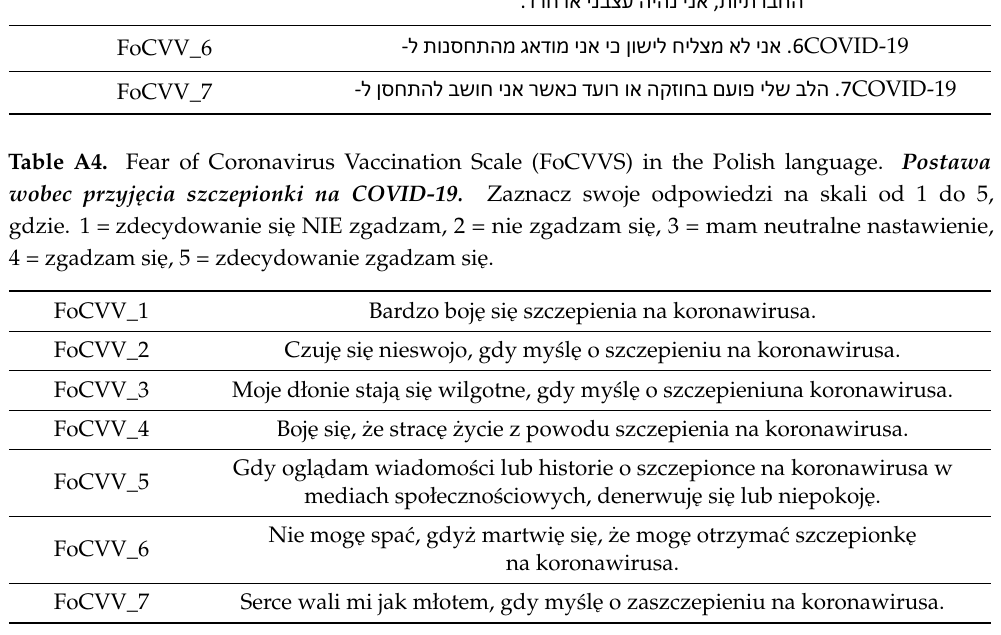
Table A5. Fear of Coronavirus Vaccination Scale (FoCVVS) in the Slovenian language. Odnos do